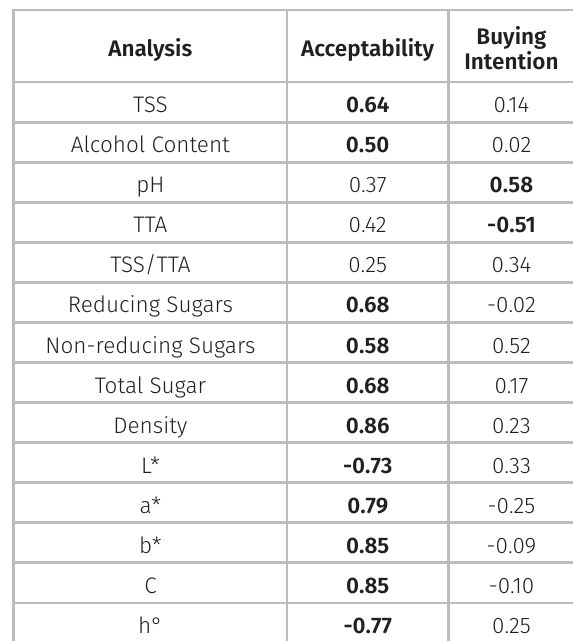
Table V. Pearson correlations between physicochemical and sensory